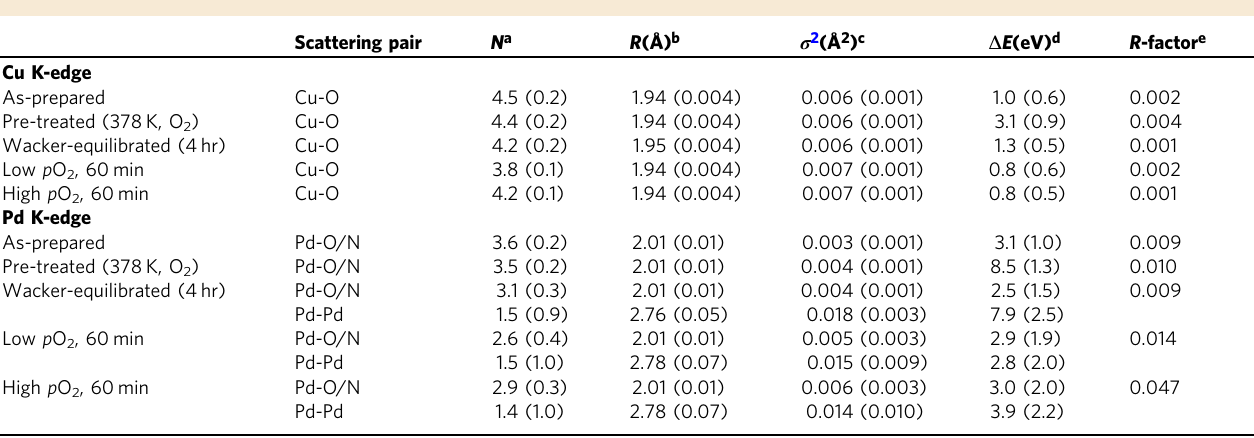
Table 2 Best- fi t EXAFS parameters for Pd1Cu5-Y.